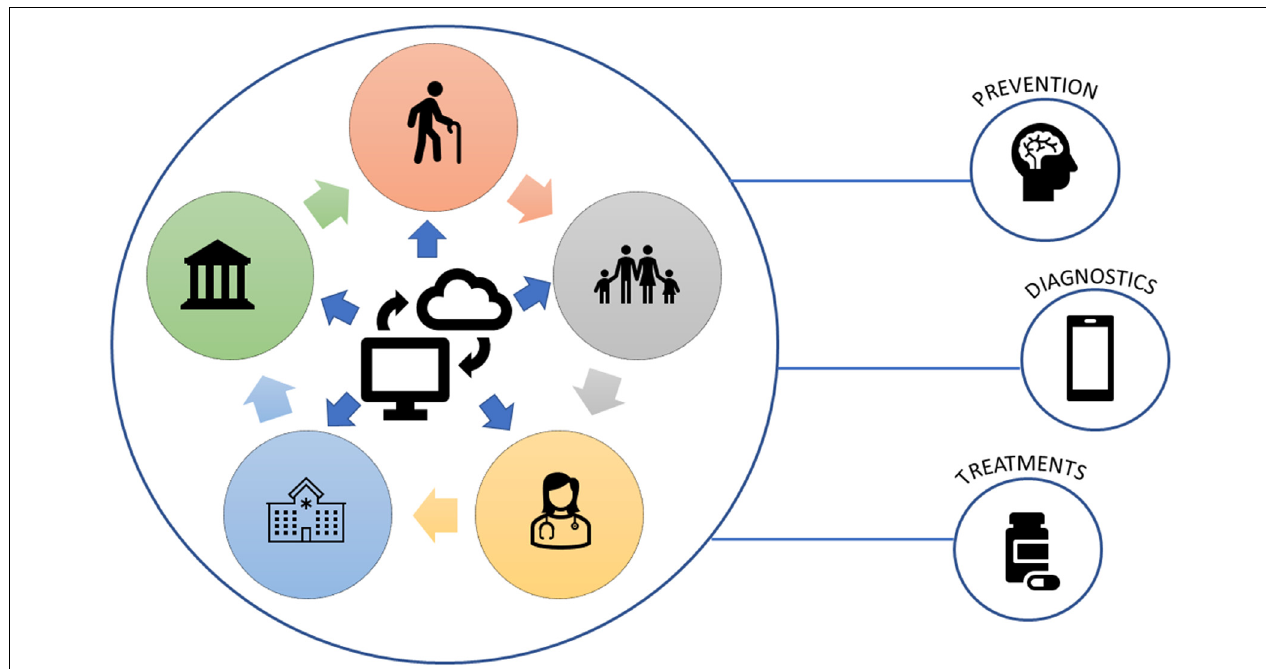
FIGURE 1 | Networking and collaboration among different stakeholders: a fundamental chain in the improvement and identification of new preventive strategies, diagnostic tools, and effective treatments against